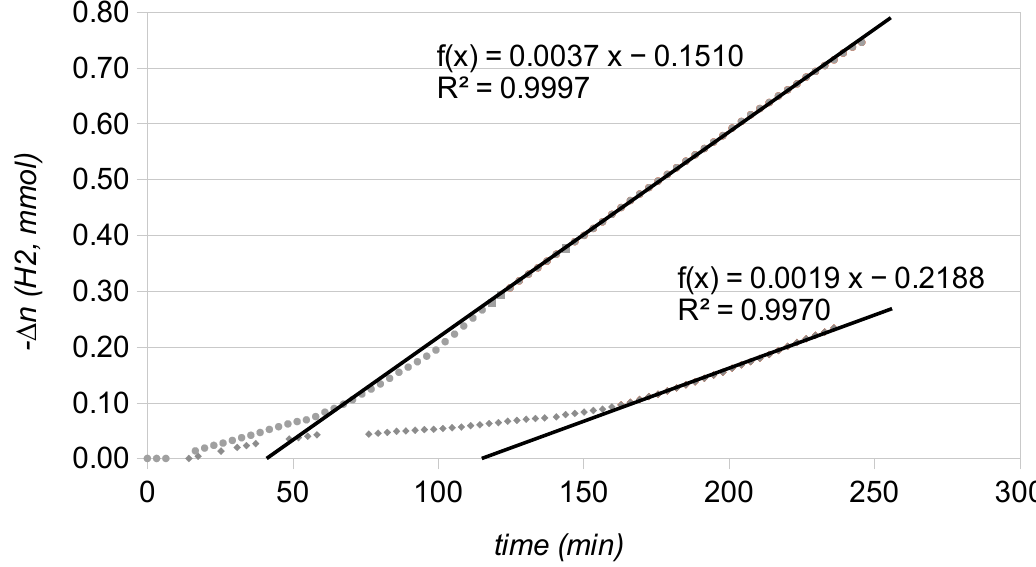
Figure 3. Kinetic plots of the overall H 2 consumption in the DS with Pd/mS-pSDVB10-3N (51.5 mg, diamonds; 100.3 mg,